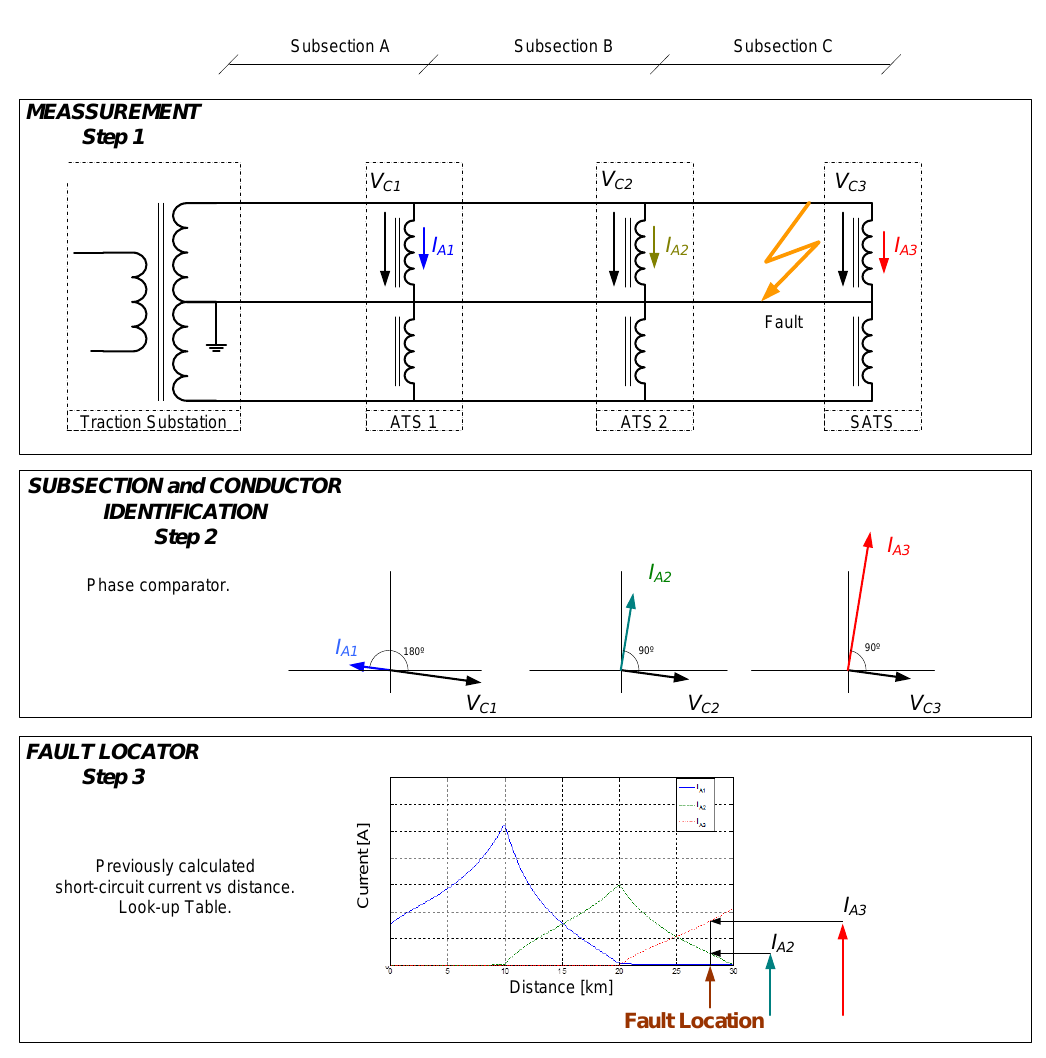
Figure 6. Simplified layout of the location method.